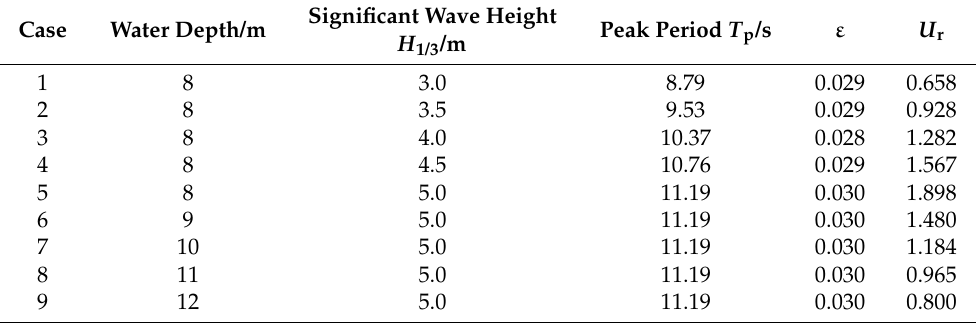
Table 2. Numerical simulating